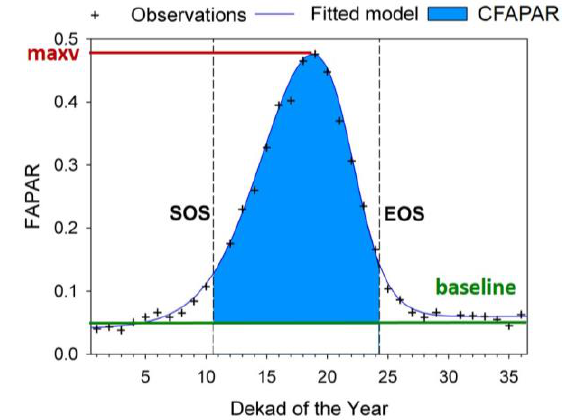
Figure 3. Visualisation of the CFAPAR